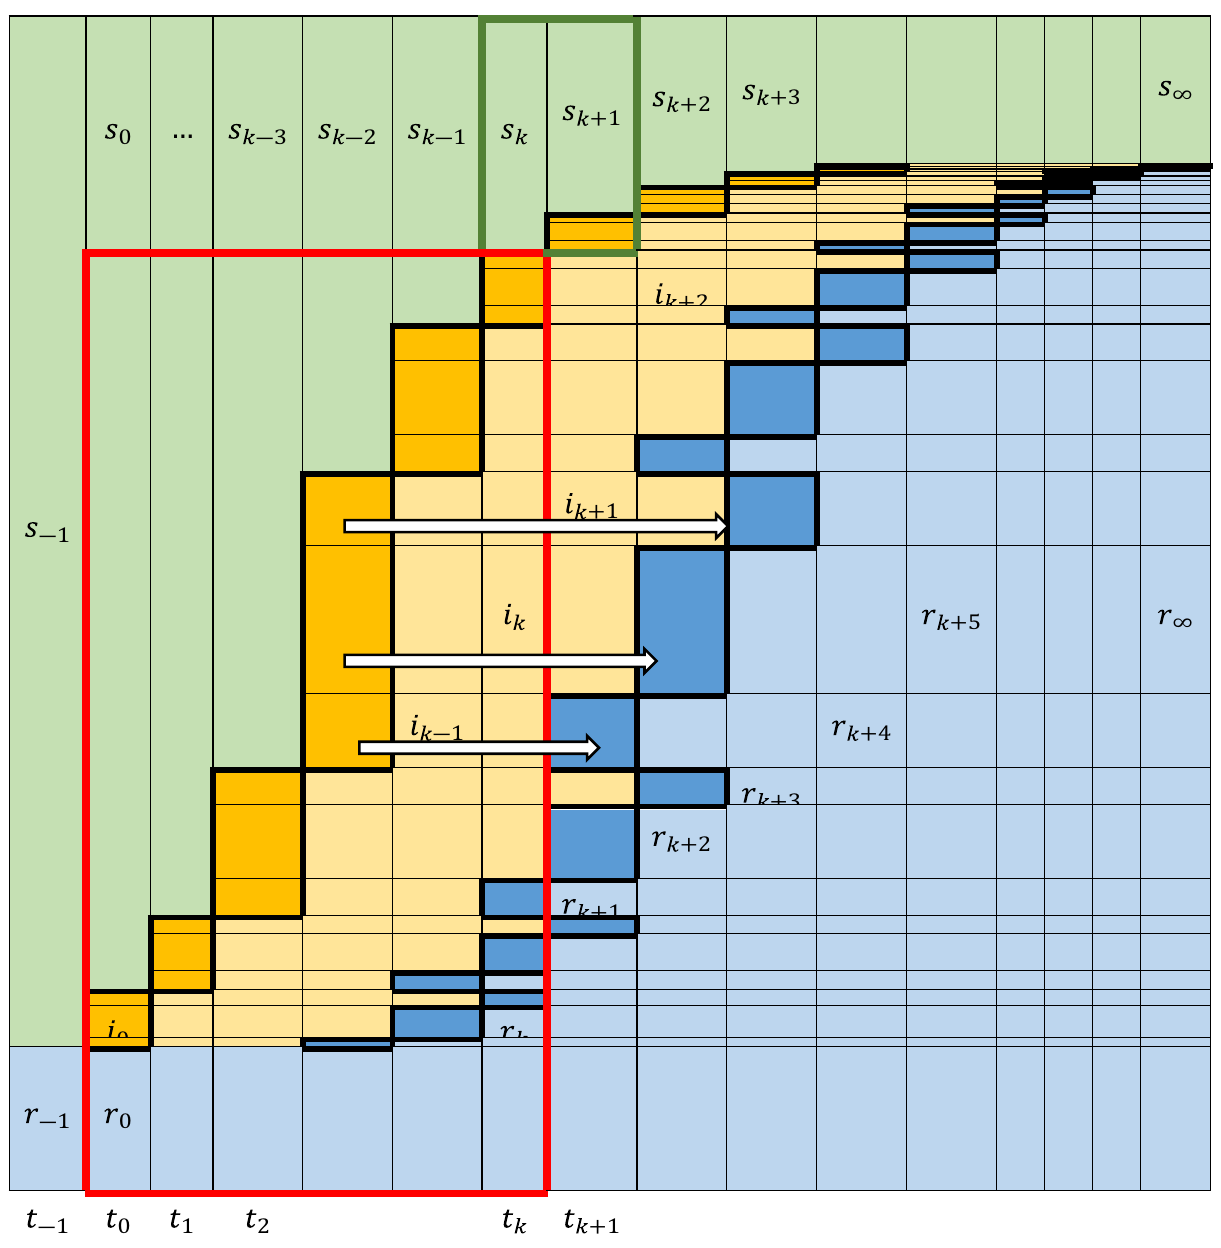
Figure 2. Schematic of time-varying susceptible ( s , green), infectious ( i , orange), and removed ( r , blue) fractions of a fixed-size population after an initial infection, i 0 , at discretized time t 0 . Each new part of the infectious fraction i (thick-framed orange rectangles) moves to the removed fraction, r (thick-framed blue rectangles) piecewise in a number of time steps following a certain distribution. The population eventually , r 1 s , and i 0 . The pattern analogy with the stacked chart in Fig. 1 is reaches a steady state at s − ∞ ∞ = ∞ ∞ =